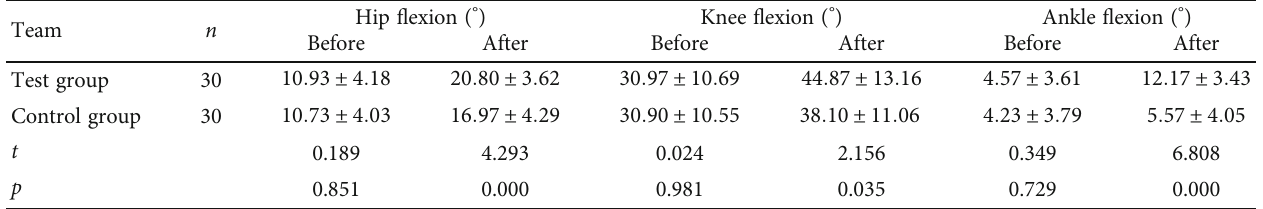
Table 2: Change of angle of hip fl exion, knee fl exion, and ankle fl exion.